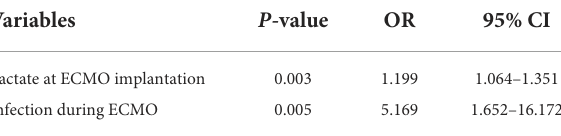
TABLE 3 Multivariable logistic regression analysis: independent predictors of in-hospital